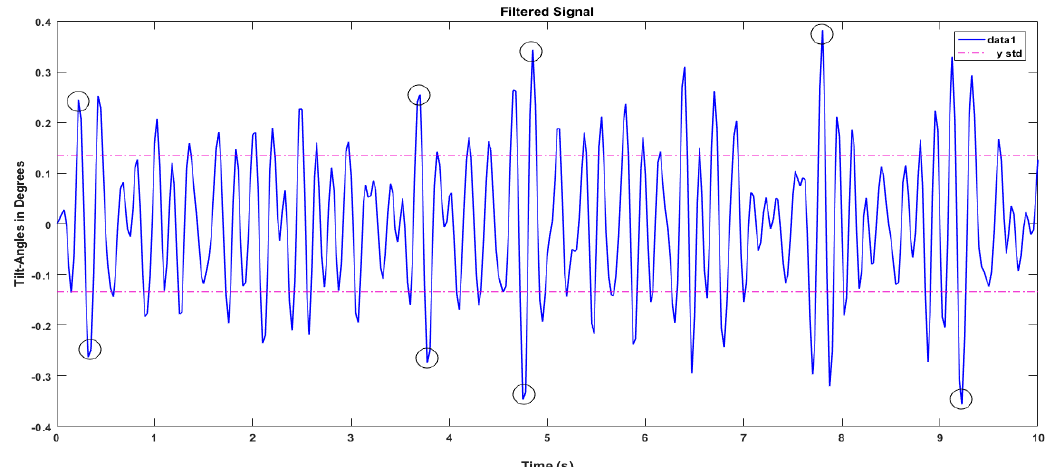
Figure 5. The runtime signal mean calculation and incremental peak mapping sequence.